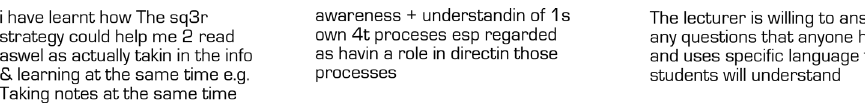
Figure 6. Examples of text messages received from